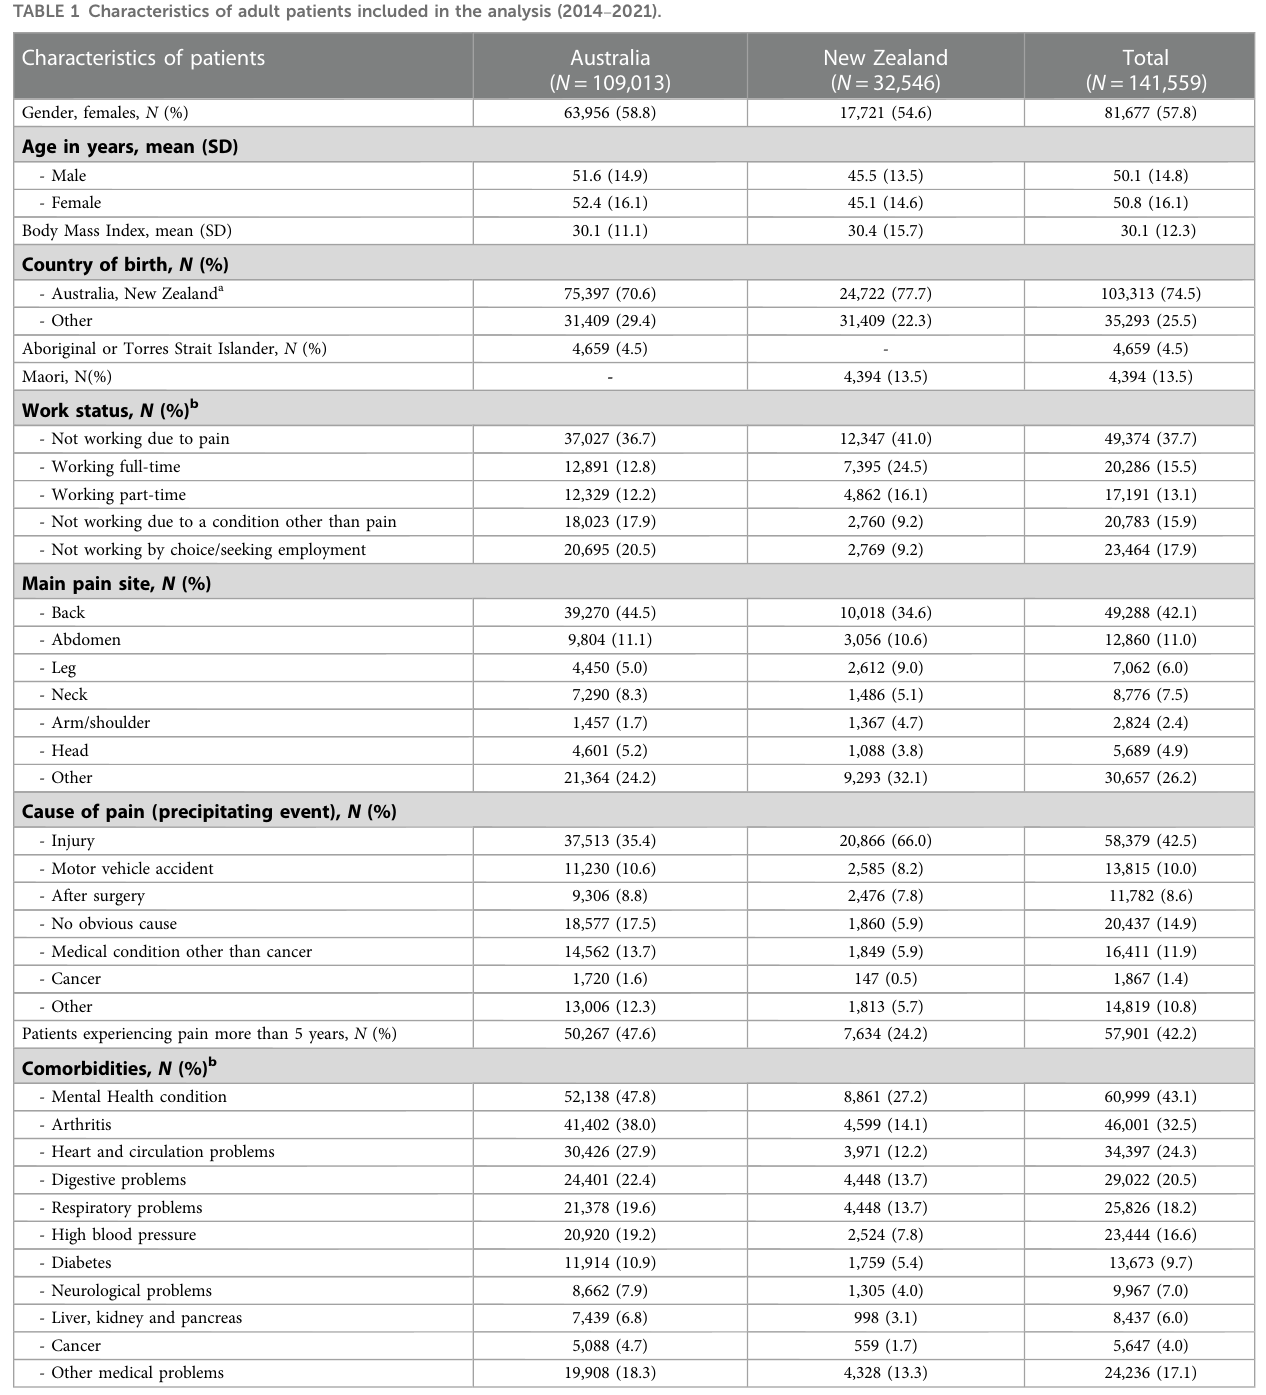
TABLE 1 Characteristics of adult patients included in the analysis (2014 – 2021). Characteristics of patients Australia